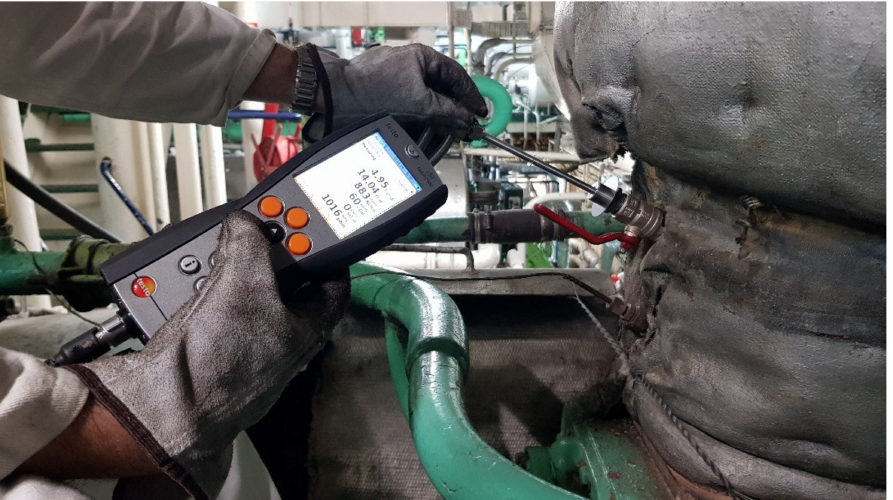
Figure 2. Sampling point located after the